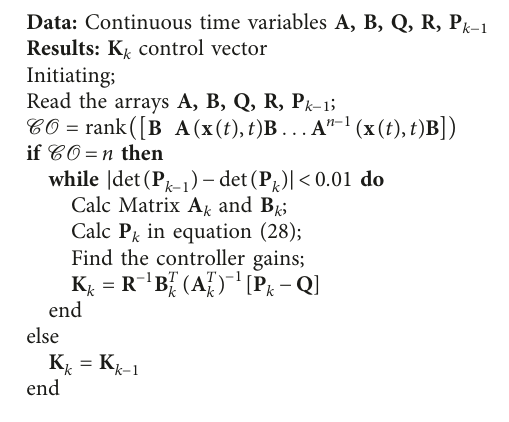
A LGORITHM 1: Calculation of control vector K k for control